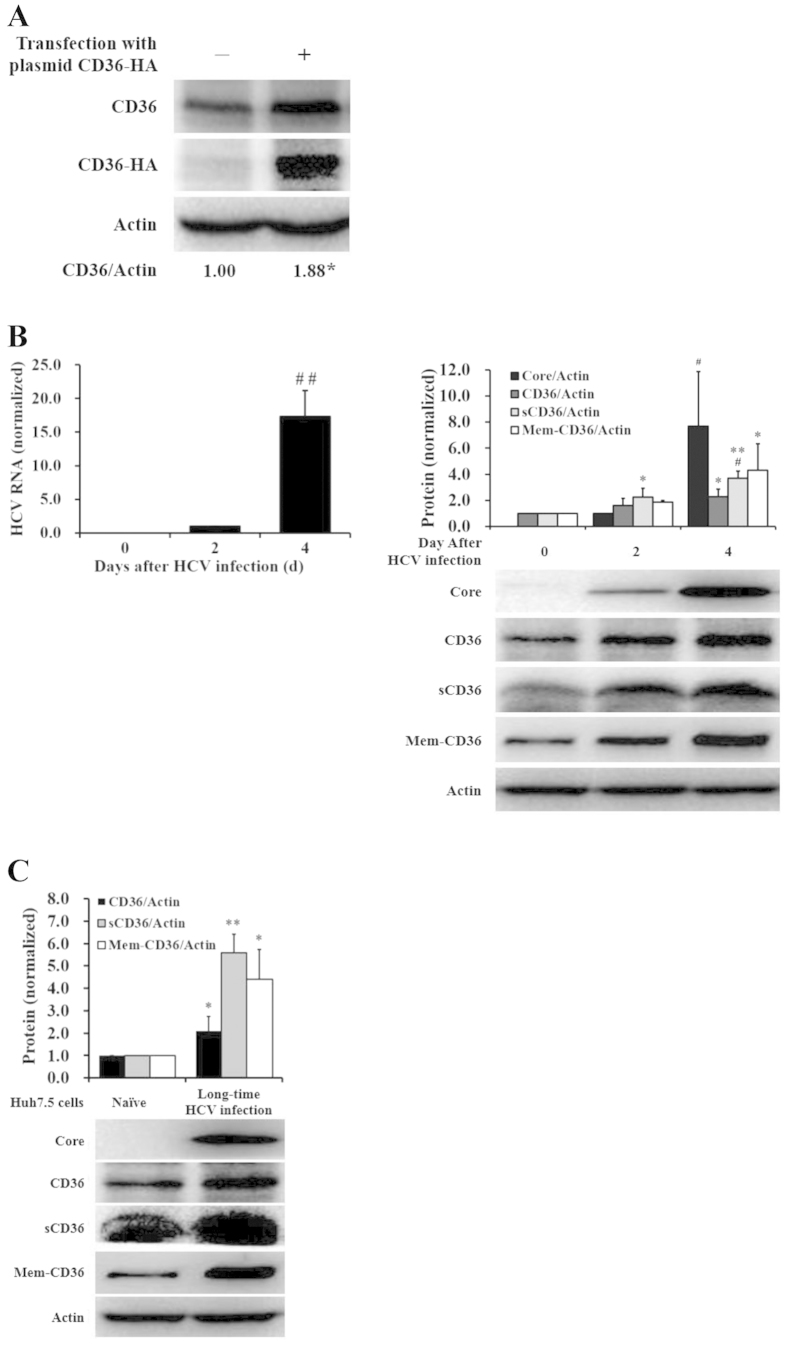
HCV infection increased CD36 expression in vitro.(A) CD36 expression on naïve Huh7.5 cells was confirmed with the band at the site of exogenous CD36-HA detected with anti-HA antibody. The ratio of CD36/Actin is the average taken from 4 independent experiments (*P < 0.05 vs plasmid control (−)). (B) HCV infection increased CD36 expression on Huh7.5 cells and elevated sCD36 in culture supernatants (n = 3; *P < 0.05 and **P < 0.01 vs day 0; #P < 0.05 vs day 2). (C) CD36 expression and sCD36 secretion were increased on Huh7.5 cells infected with HCV for over 60 days (n = 3; *P < 0.05 and **P < 0.01 vs naïve control). Huh7.5 cells were infected with HCV (45IU/cell), proteins and intracellular HCV RNA were respectively detected with WB and qRT-PCR at indicated days after infection in (B,C). The protein bands presented in the figure showed the results of a representative experiment. Data presented are mean ± standard deviation. Student’s t-test was used.